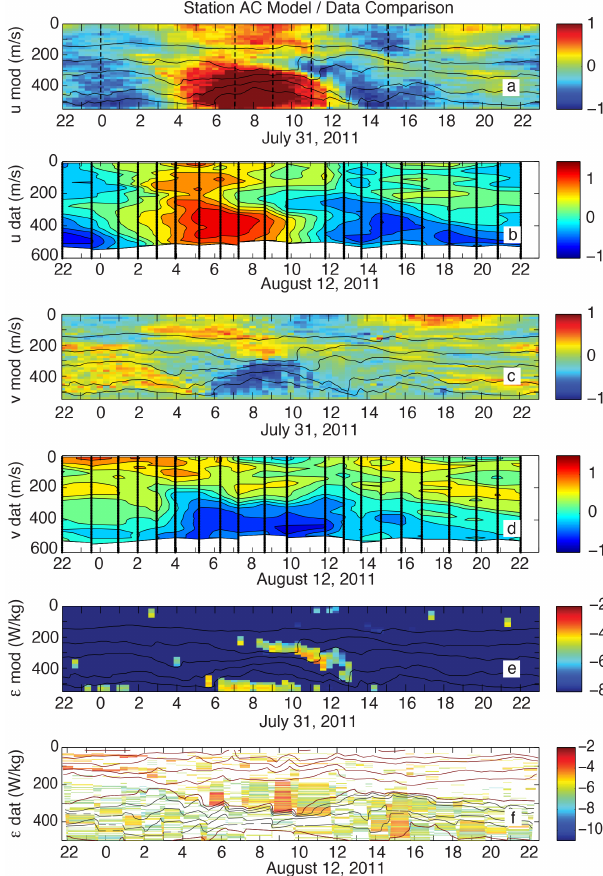
Figure 12. Model/data comparisons between observations at An- chor Station AC and output from the MITgcm model. The model output is from the same location but a fortnight earlier, during the same phase of the tide (see Fig. 1, bottom panel). Shown for com- parison are the u component (a, b) ; the v component (c, d) ; and turbulent dissipation (e, f) . The lines on the bottom plot represent density, with a contour interval of 1.0 sigma-T units (red) and 0.5 sigma-T units (gray). The vertical dotted lines in panel a) represent the times of the model cross-sections shown in Fig. 13. The verti- cal solid lines in (b) and (d) represent the times of the individual CTD/LADCP casts.